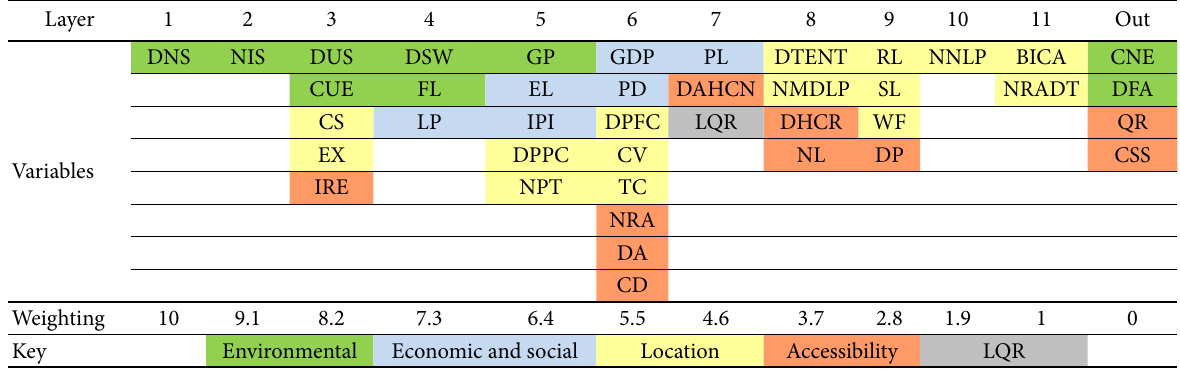
Table 3. Layer distribution of each variable according to depth on Bayesian Network Layer